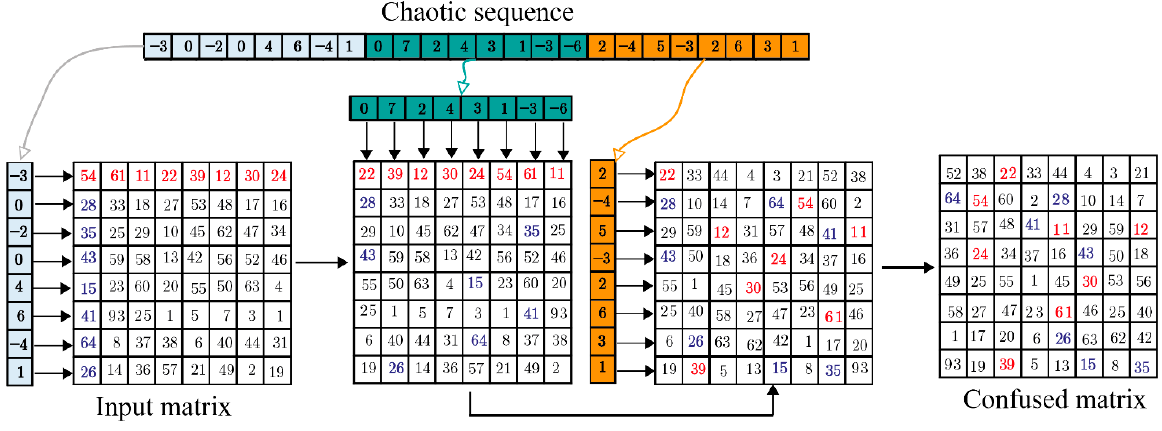
− 0.0107 Figure 12. Standard images of sizes 512 512 ×